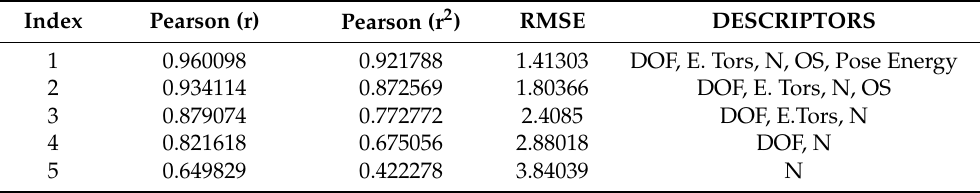
Table 6. Descriptors used in QSAR model for antimicrobial activity against S. aureus.